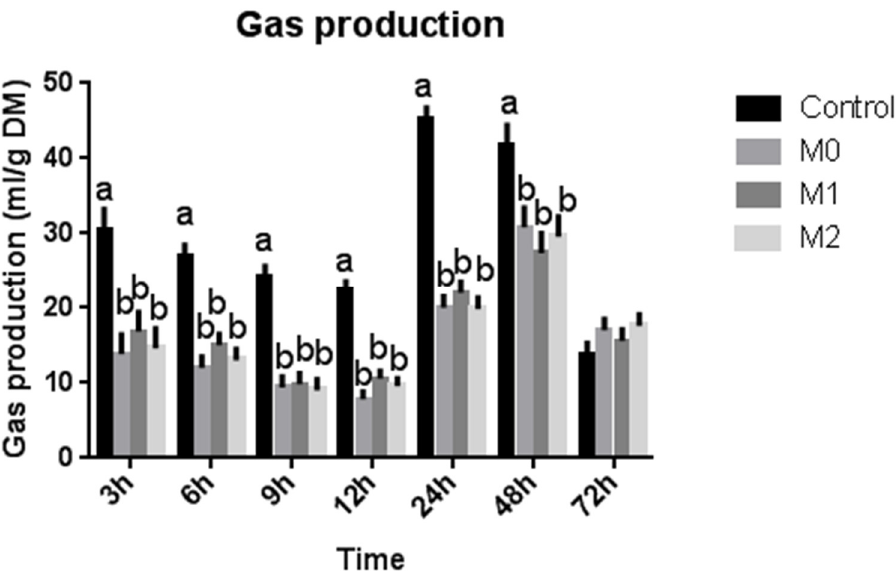
Figure 1. Total gas production at different time intervals (bars at one time interval with different letters indicate significant difference at p < 0.05).